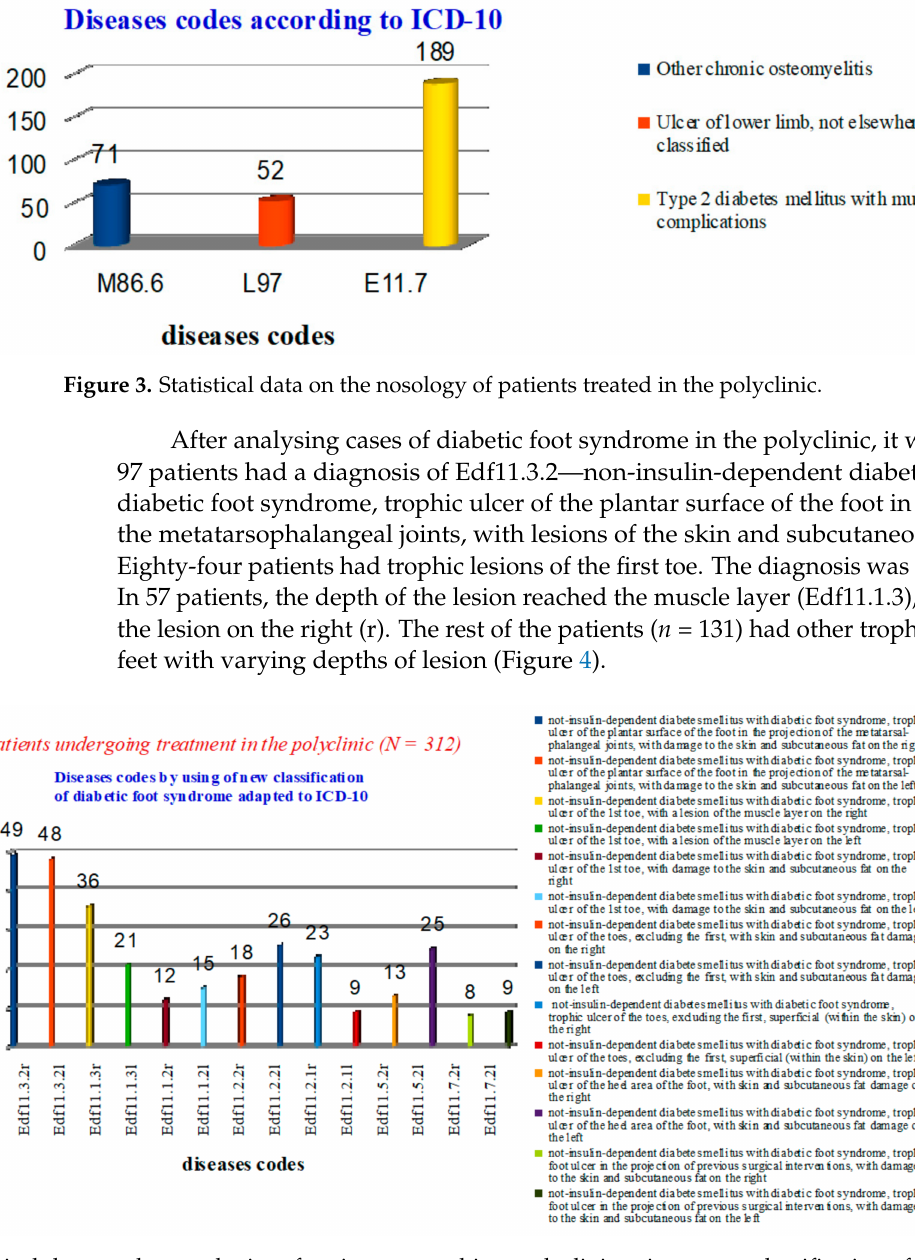
Figure 4. Statistical data on the nosologies of patients treated in a polyclinic using a new classification of diabetic foot syndrome, adapted to